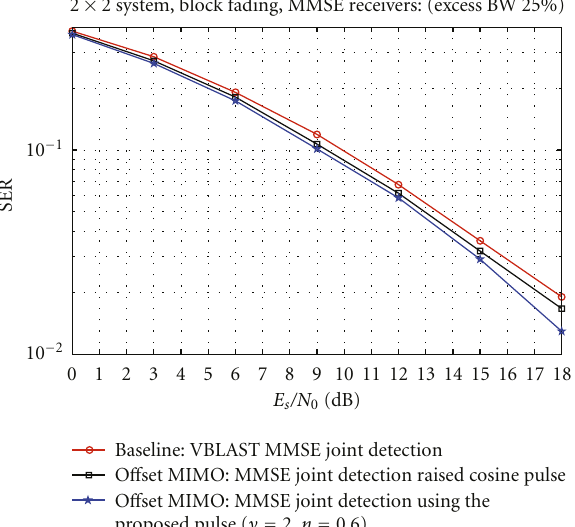
Figure 16: Performance of new pulse shaping.